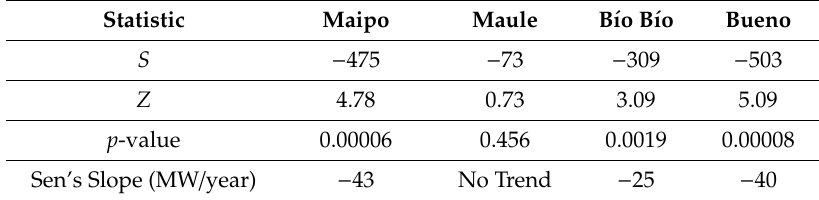
Table 4. Trend analysis of future period